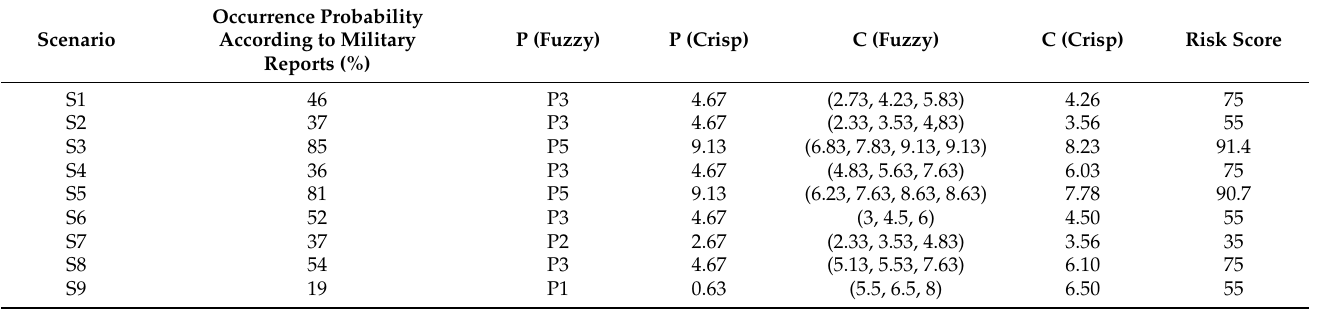
Table 7. Expert opinions and risk score for all considered scenarios.